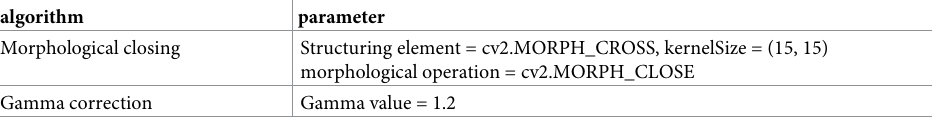
Table 4. Selected parameter values for morphological closing and gamma